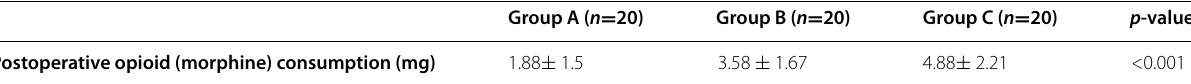
Data are presented as mean and standard deviation Regarding postoperative opioid consumption, there was a statistical significance between the three groups with higher opioid consumption in both the femoral and adductor groups P value less than 0.05 was considered statistically significant